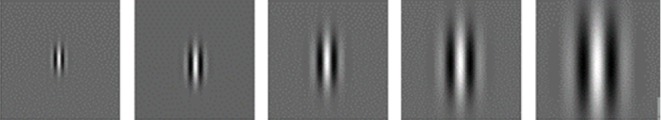
The two-dimensional Gabor wavelet function at different scales.